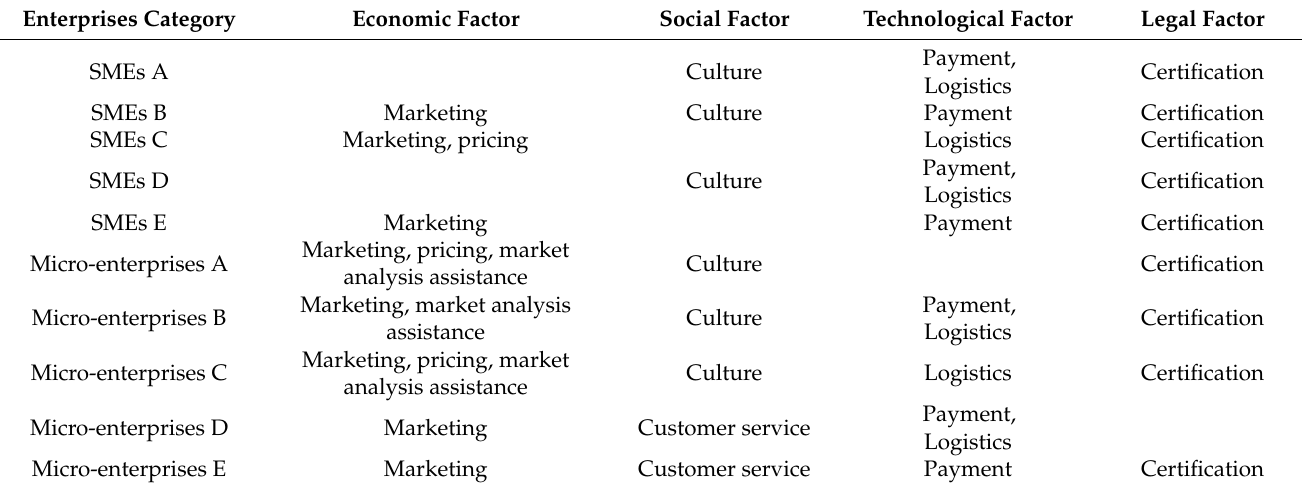
Table 4. Considerations for SMEs and